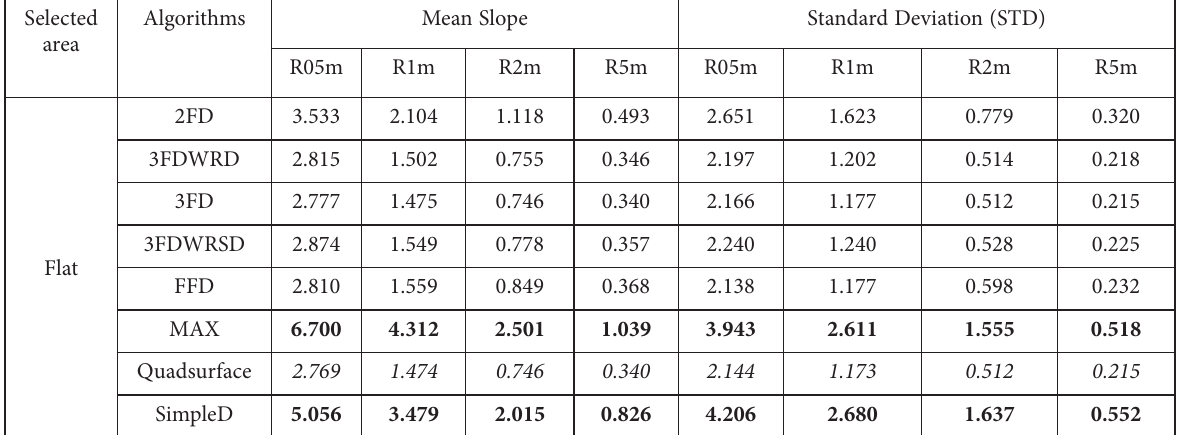
Table 1. The mean and standard deviation of estimated slope from different algorithms in flat and steep area at four resolutions Selected Algorithms area